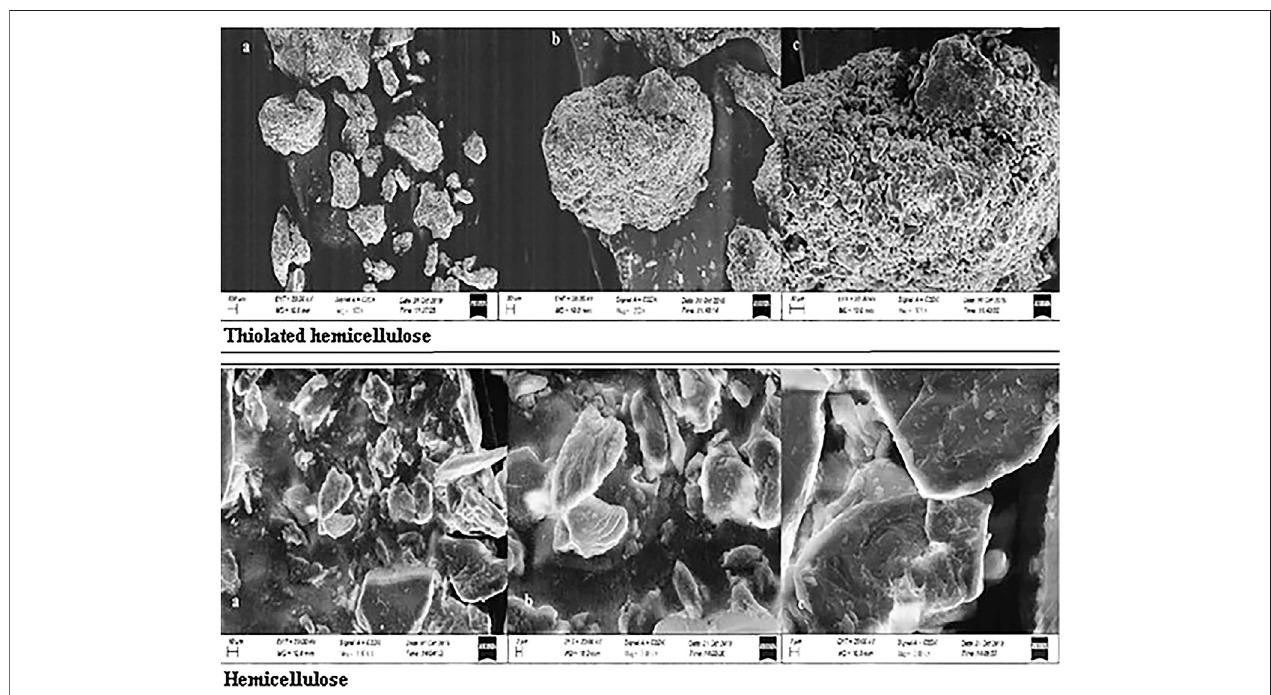
FIGURE 5 | SEM images of Thiolated Hemicellulose and